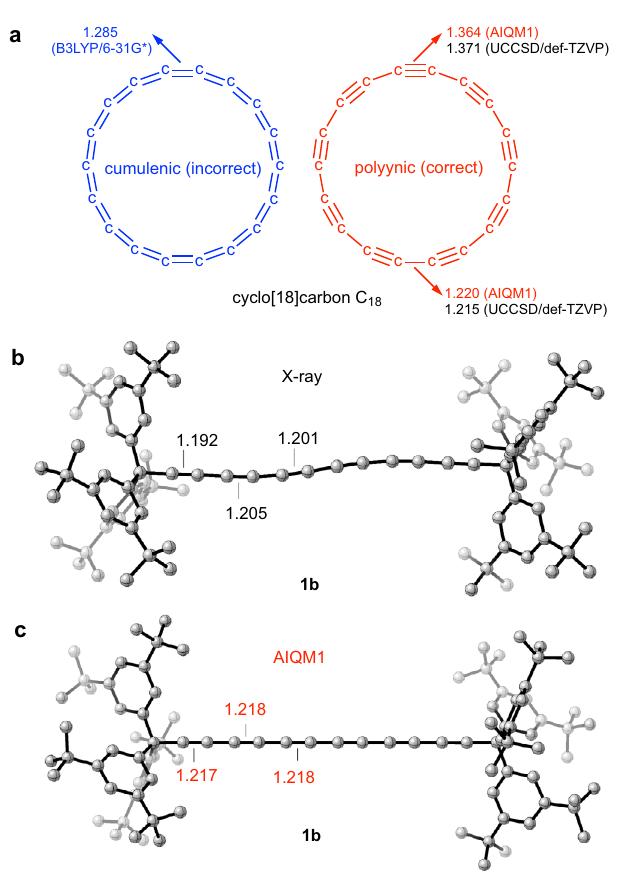
Fig. 7 Geometries of polyyne compounds. a Correct polyynic (red) geometry of C 18 predicted by AIQM1 (bond lengths in red) and UCCSD/def-TZVP (bond lengths in black from ref. 56 ) and its incorrect alternative cumulenic (blue) geometry predicted by B3LYP/6-31G* (bond lengths in blue). b X-ray structure of 1b compound from ref. 57 assigning too short triple C ≡ C bond lengths (shown in black). c AIQM1 geometry of 1b with revised bond lengths (shown in red). Bond lengths are in Å. Other bond lengths and the coordinates of AIQM1 geometry are given in the Supplementary Data 1 sheet S23.